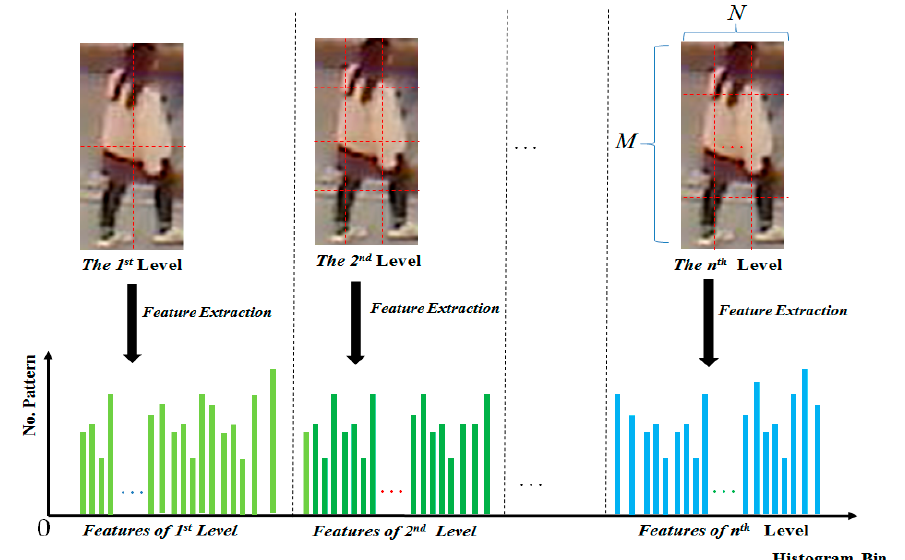
Figure 4. Multi-level local binary pattern (MLBP) image features extraction from a human body image.